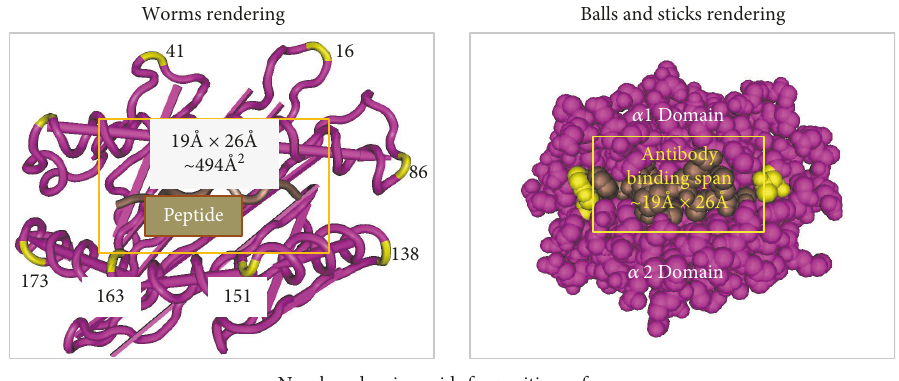
Figure 3: Top view of HLA class I heavy chain 1 and 2 domains. Rectangles show approximate binding span area of antibody.